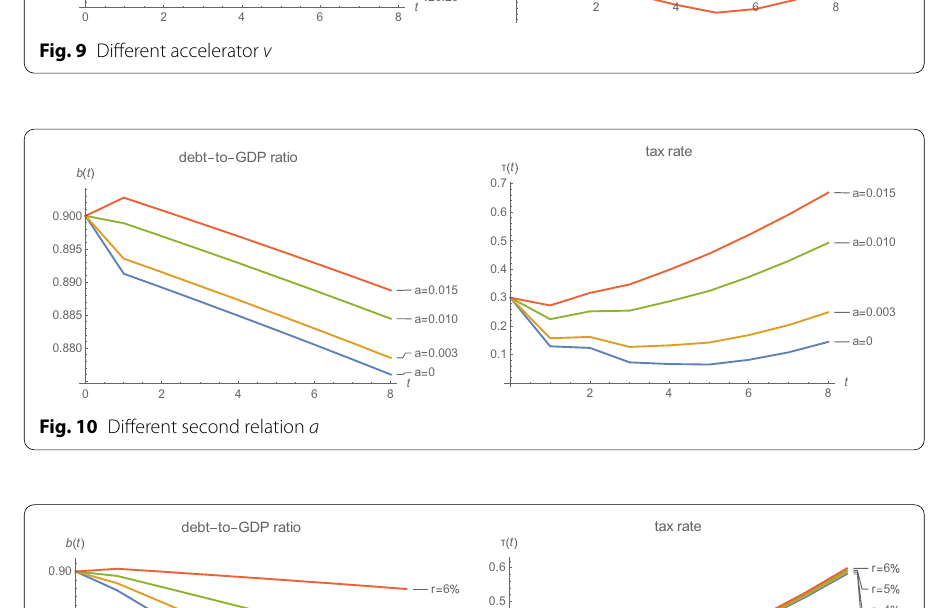
Fig. 10 Different second relation a